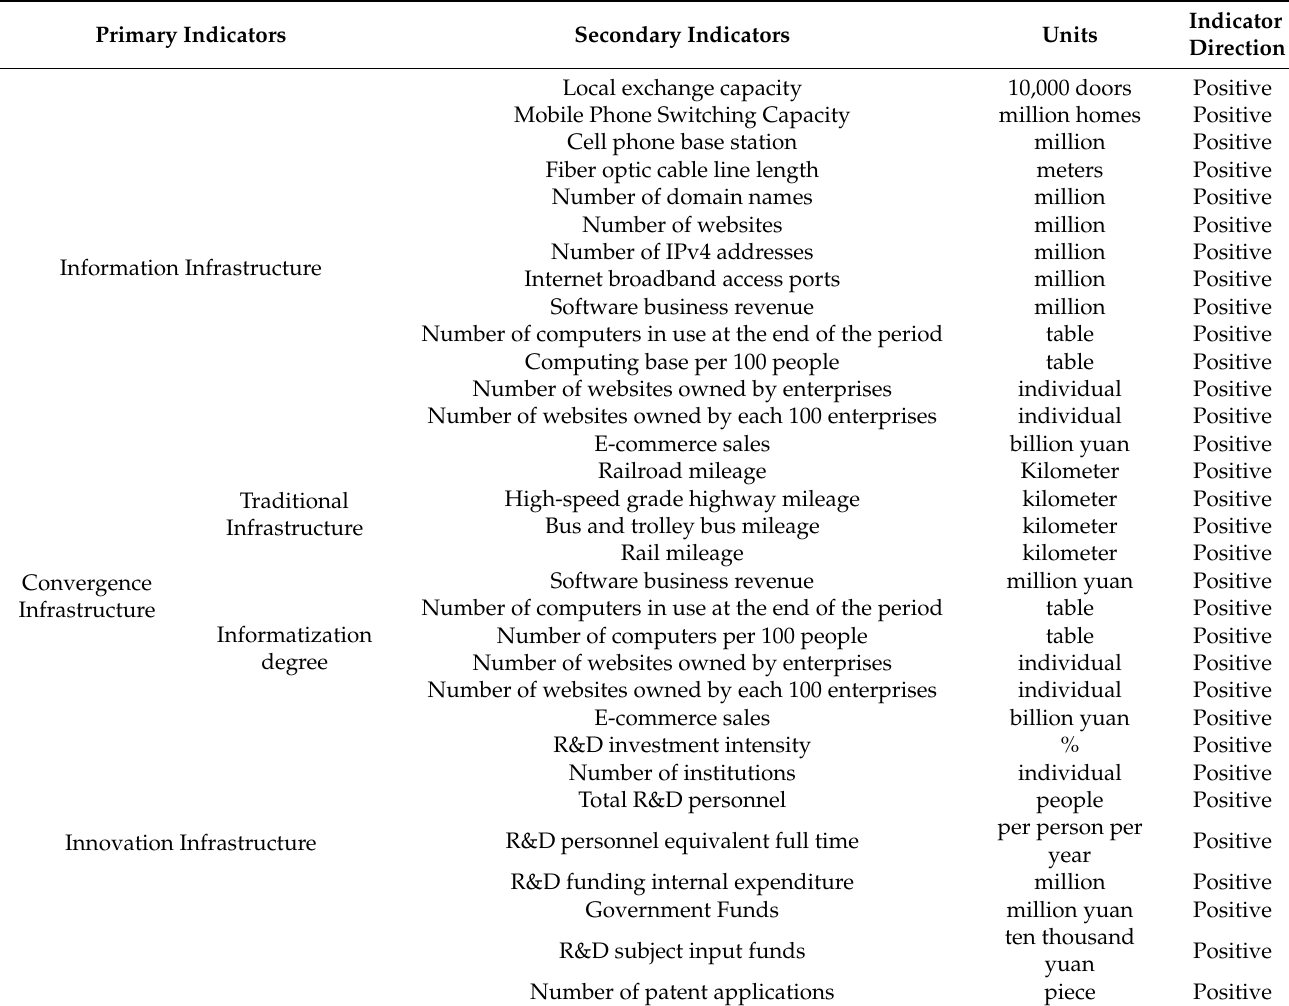
Table 3. New digital infrastructure indicator